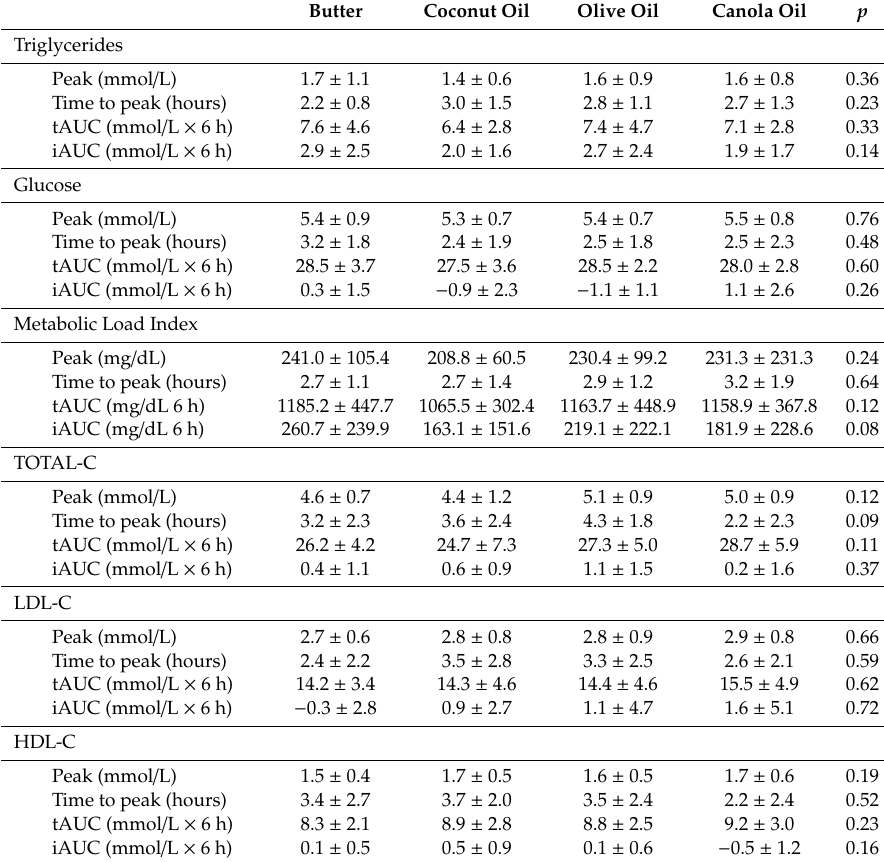
Table 3. Postprandial metabolic outcomes for the four meal